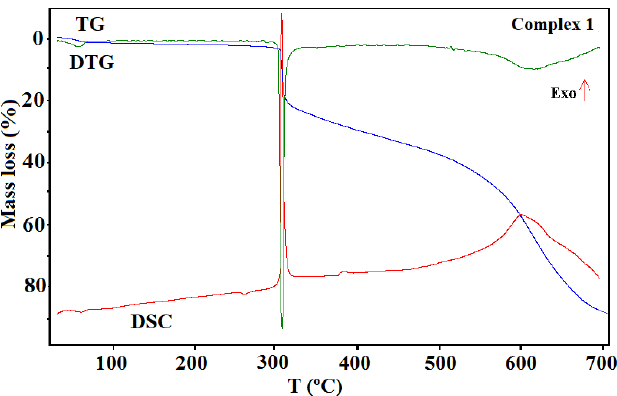
Figure 11. The thermogravimetric (TG), the differential thermal analysis (DTG), and the differential scanning calorimetric (DSC) curves of the thermal decomposition of complex 1 in air.